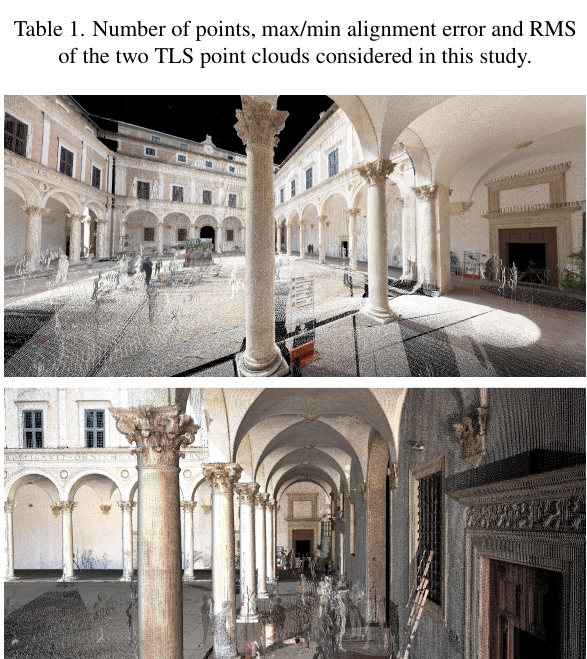
Figure 1. Two views of the point cloud of the Laurana’s Courtyard of Honour: general perspective and detail, in